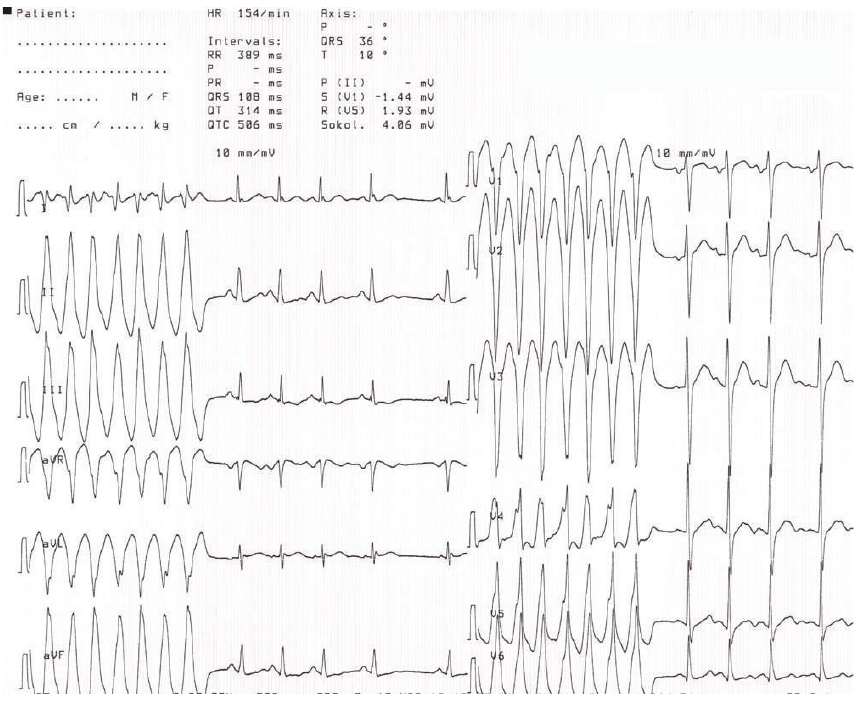
Figure 1: Electrocardiogram showed sinus tachycardia and non-sustained, monomorphic ventricular tachycardia.